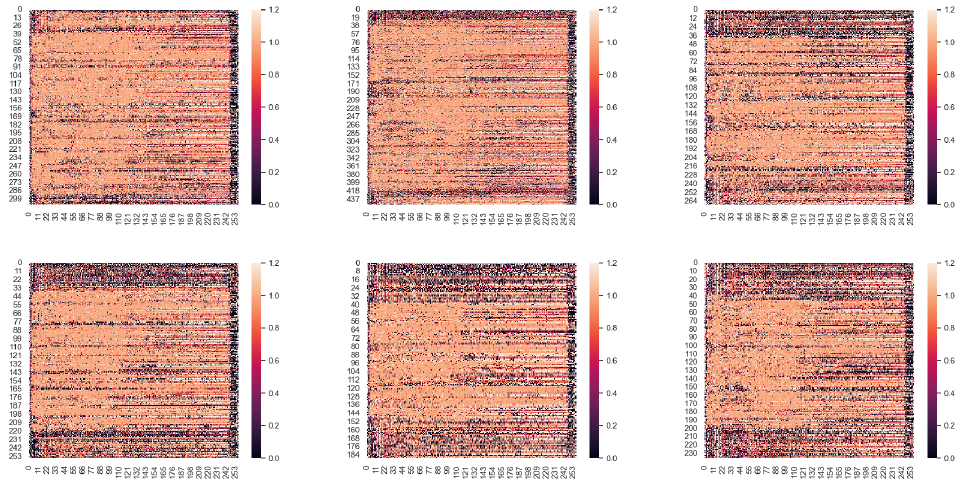
Figure 13. Phase enhancement masks for different noise speech. Lighter colors represent larger